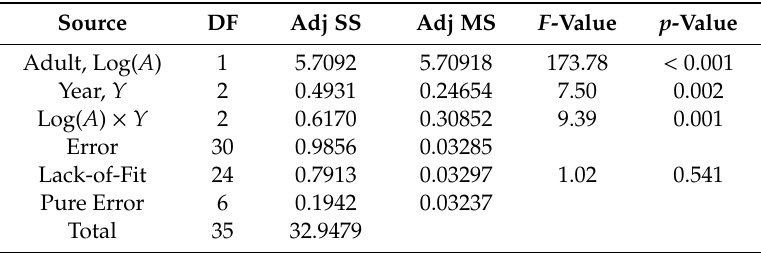
Table 4. General linear model (Equation (4)) of the e ff ects of emerging adult density ( A ), Year ( Y ) and pheromone treatment ( T ) on apparent fecundity, the ratio of eggs to adults ( E / A ). Reduced